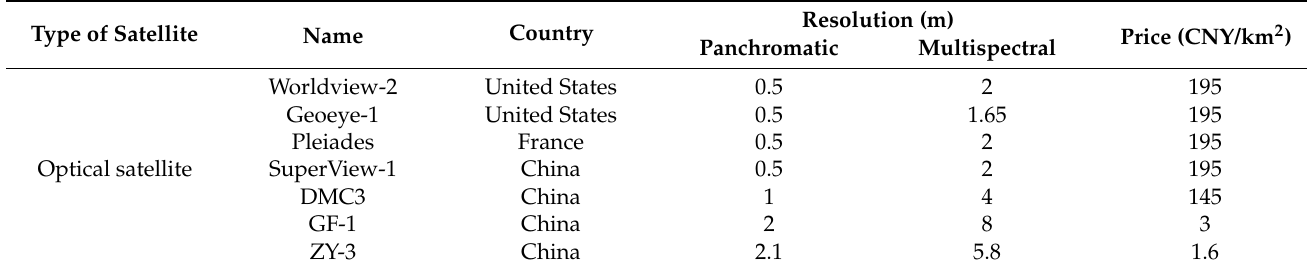
Table 6. The image prices of some popular satellites in service